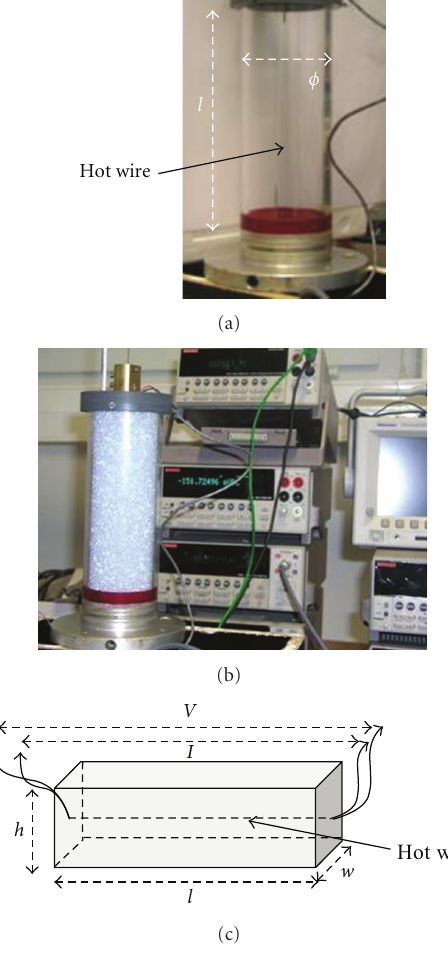
Figure 1: Details of the Transient Hot-Wire device. (a) Cylindrical cell used for the glass-bead assemblages. (b) Cylindrical cell filled by the beads and Keithley current generator and nanovoltemeter. (c) Schematic representation of the earth brick and lime-hemp brick instrumentation ( l = 29 . 5 cm, h = 9 . 5 cm, w = 14cm).